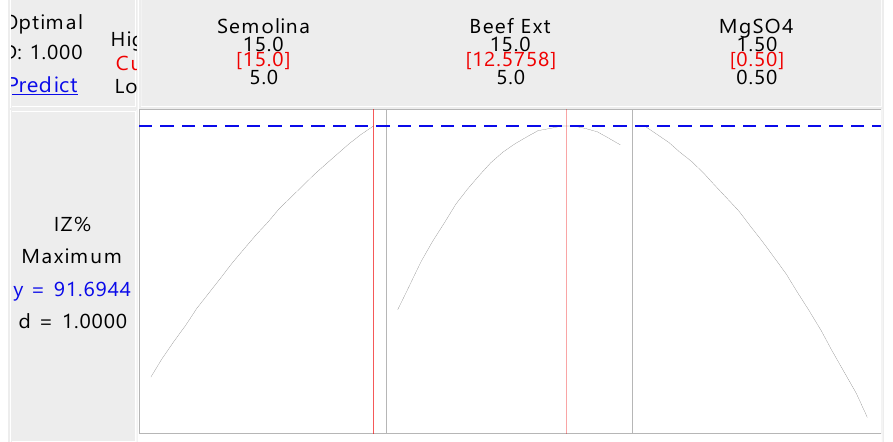
Figure 2. Predicted and actual values of media composition and inhibition zone against C. arachidichola .